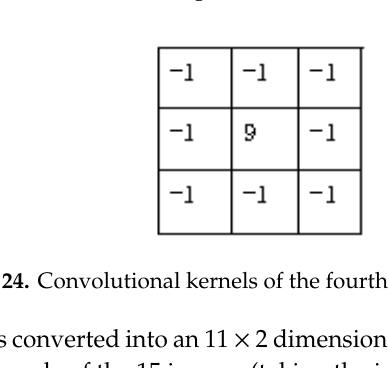
Figure 25. An example of fifteen processed image formed in the fourth step. The average gray value of the 15 images is read and input into the expanded layer, and the image feature is converted into the data feature; the result of the expanded layer is 15 numbers, and the 15 numbers are the expanded parameters of an iris image. The three iris images (the original image, the smooth image, and the texture-emphasized image) are processed through the above steps, and the expanded parameters of the three images are collected. Three sets of the 15 expanded parameters can be obtained in the expanded layer. The average of the three numbers at the same position in the three sets as that of the image's recognition parameters is calculated. The recognition parameters consist of 15 numbers. 4.2.2. Iris Certification